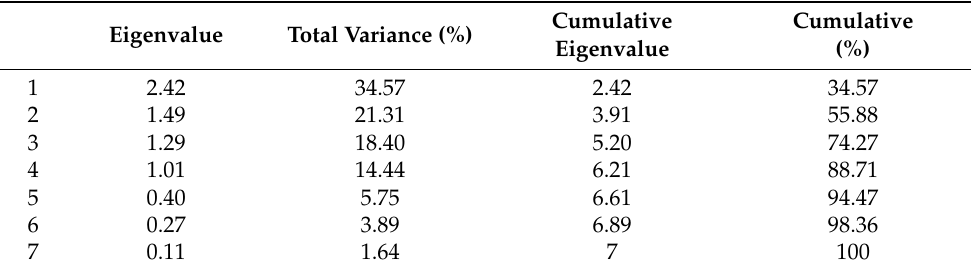
Table 4. Eigenvalues of the correlation matrix and related statistics. Percentage of variance for each component (initial eigenvalues).